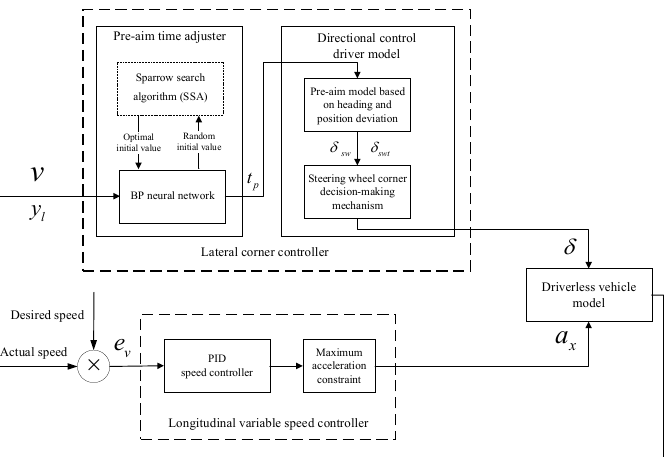
Figure 1. Block diagram of adaptive pre ‐ aim control of path tracking based on an SSA ‐ BP neural network.